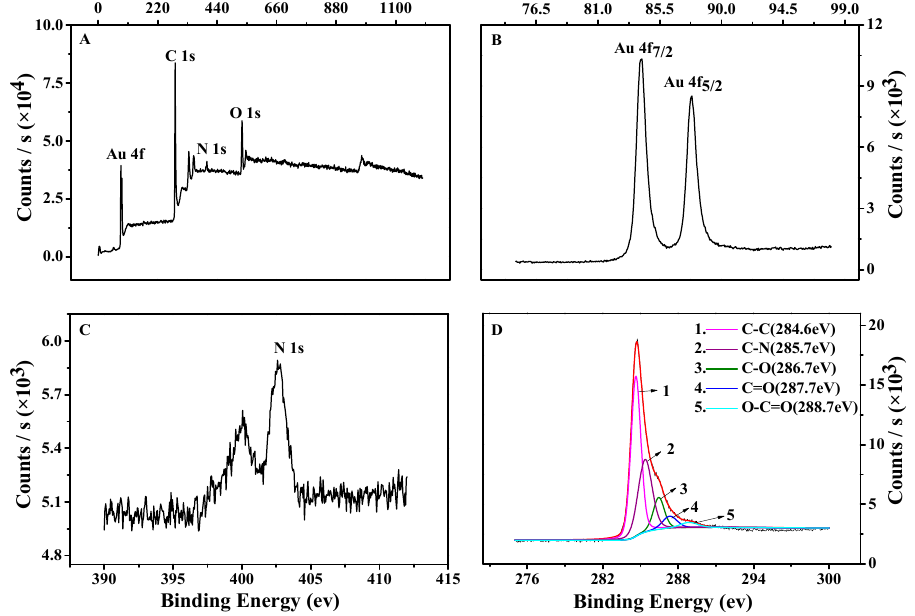
Figure 4. The X-ray photoelectron spectroscopy (XPS) spectra of TCPP–Gr/AuNPs ( A ); Au 4f ( B ); N 1s ( C ); and C 1s ( D ).